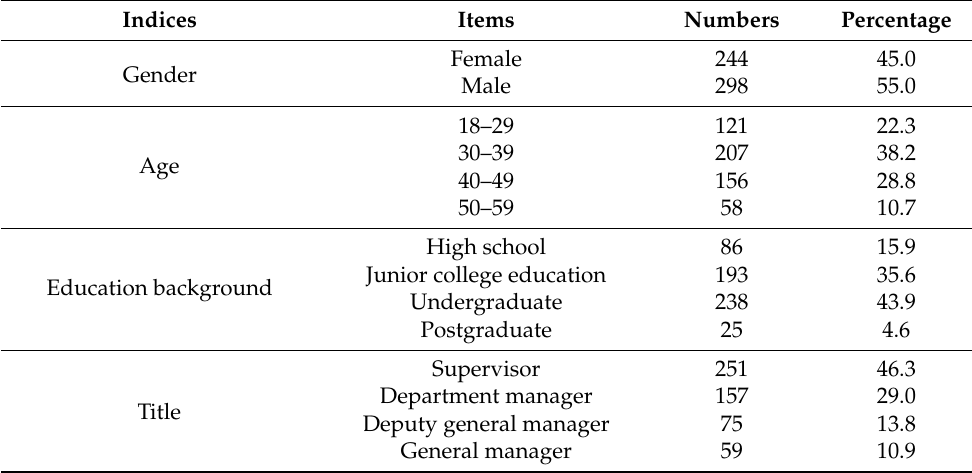
Table 2. Demographic profile of respondents.